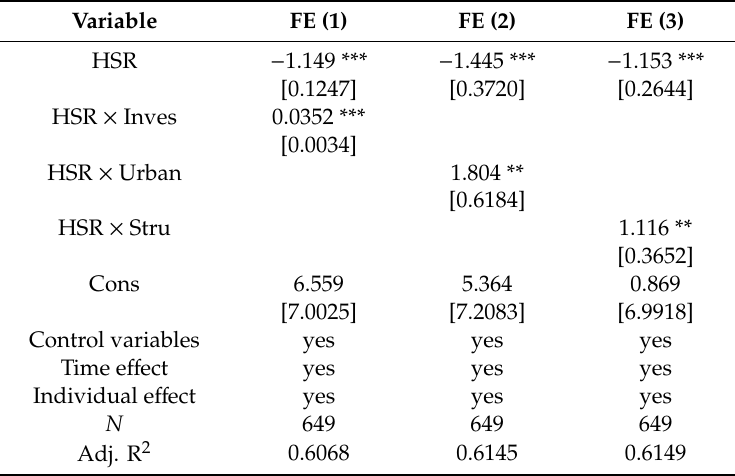
Table 4. Test of the optimization mechanism for the